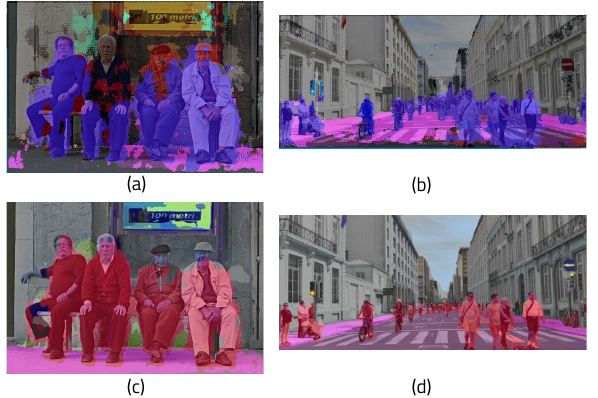
Figure 6. Results for IC-Net and ENet: ( a , b ) results for ENet; ( c , d ) results for